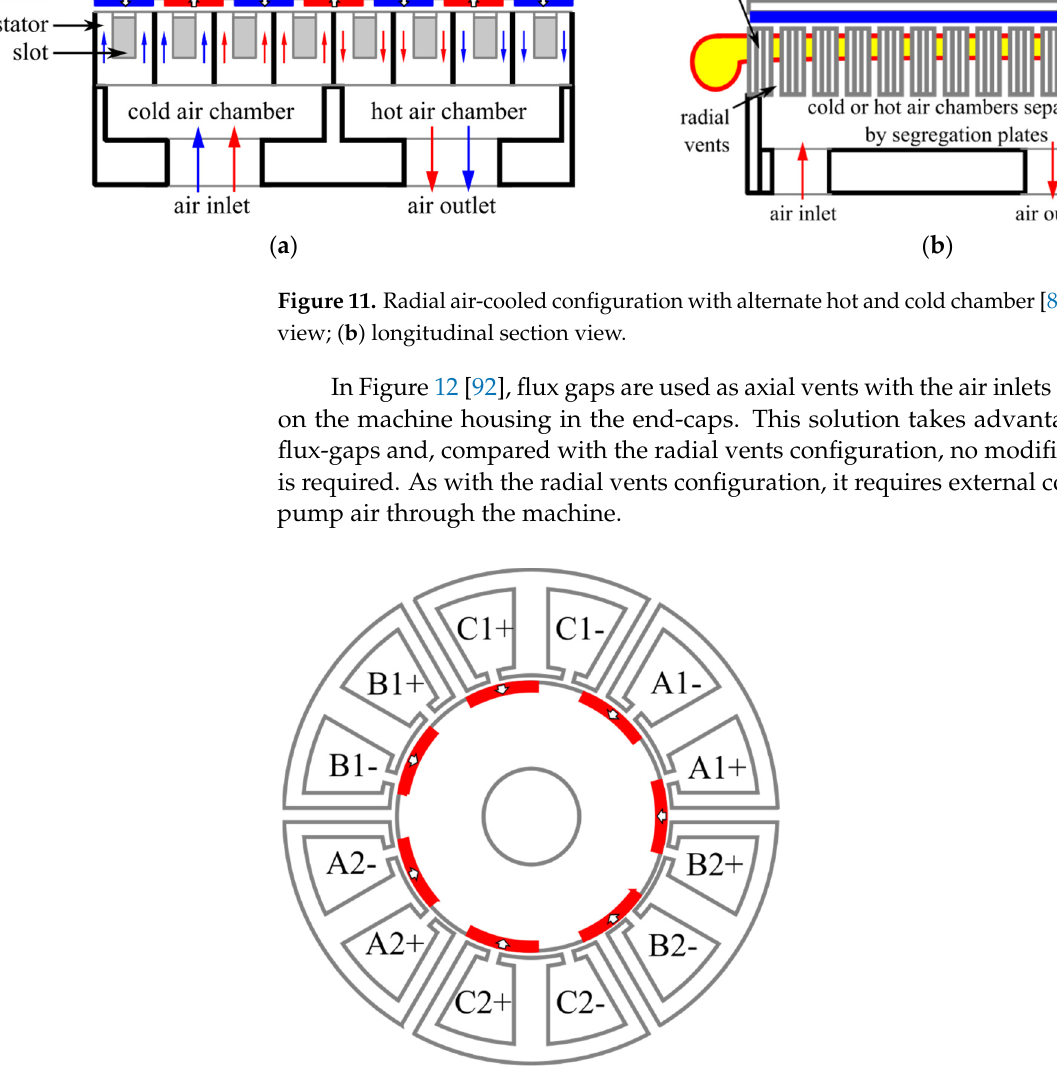
( b ) Figure 10. Symmetrical and asymmetric configurations with radial vents [87]: ( a ) asymmetric (uni- directional); ( b ) symmetrical (bi-directional).